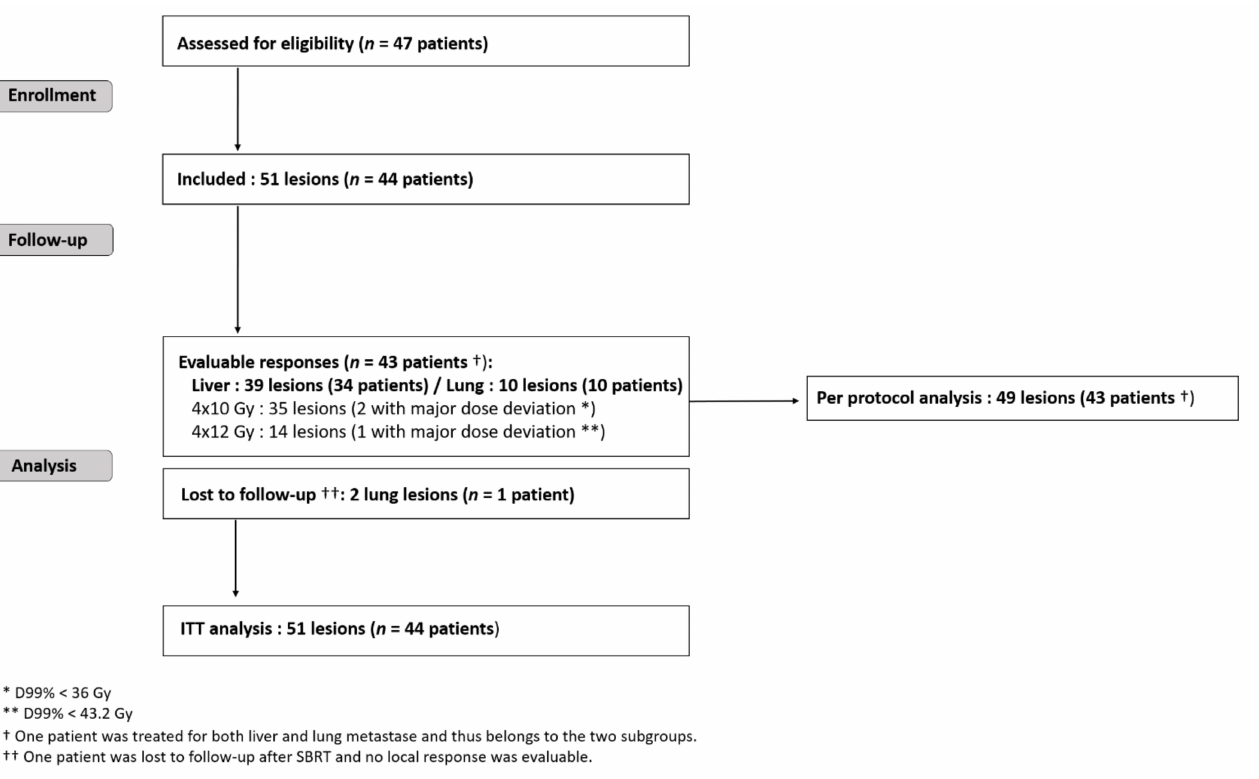
Figure 1. Trial flow-chart. SBRT = stereotactic body radiotherapy; RT = radiotherapy; CT = chemotherapy; ITT = intention to treat.